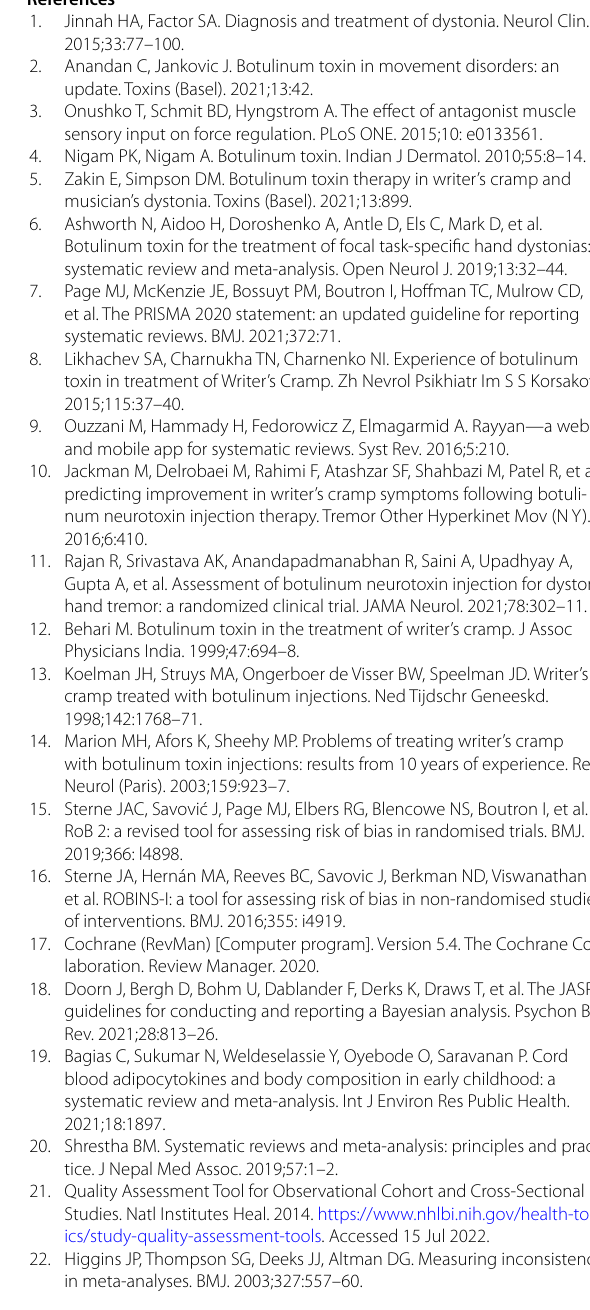
Table S2. Meta-Analysis and Meta-Regression for WCRS scores in